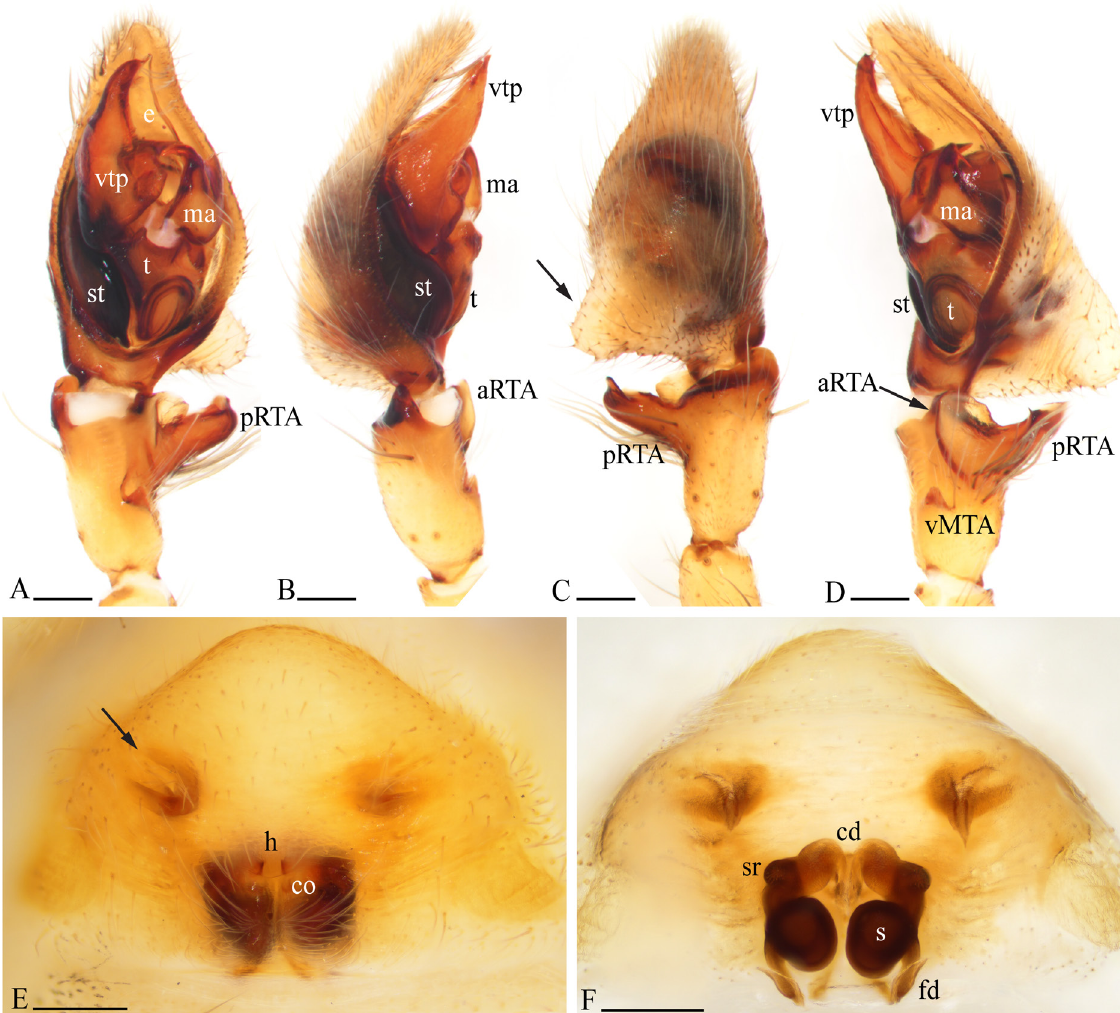
Fig. 11. Anyphaena triangularis sp. nov. A–D . Paratype, ♂ (CNAN-T01577). E–F . Paratype, ♀ (CNAN-T01579). A . Pedipalp, ventral view. B . Pedipalp, prolateral view. C . Pedipalp, dorsal view. D . Pedipalp, retrolateral view. E . Epigynum, ventral view. F . Epigynum, dorsal view. Scale bars: 0.2